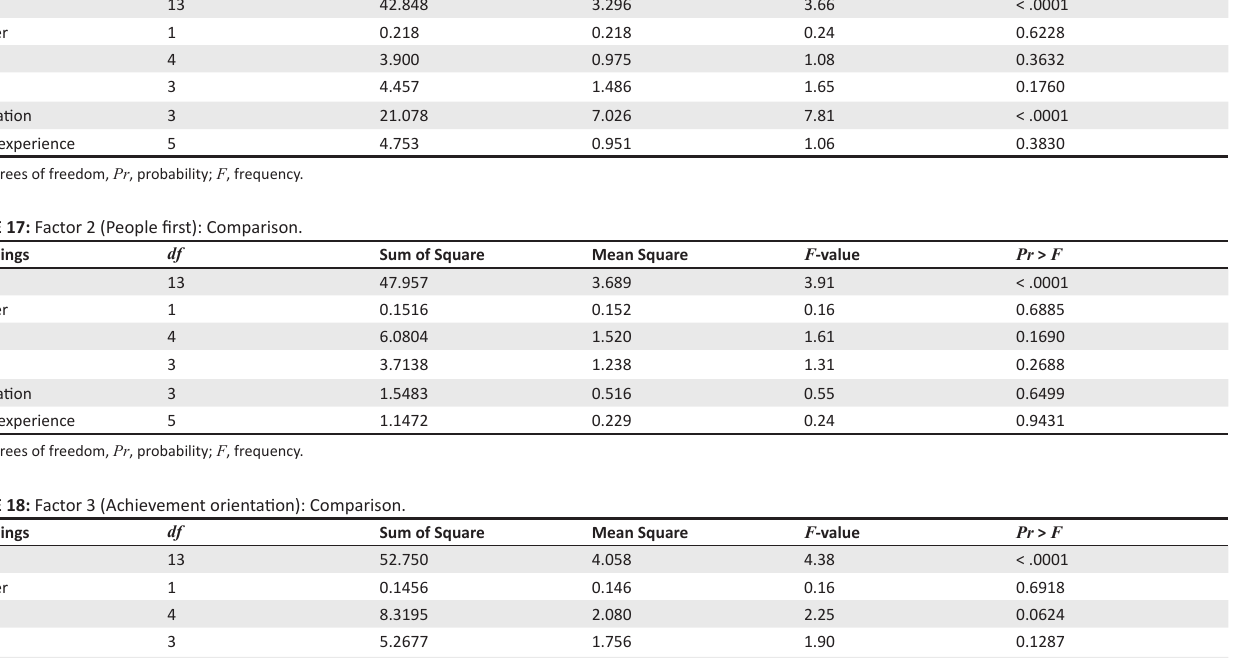
TABLE 16: Factor 1 (Leader credibility): Comparison. Groupings